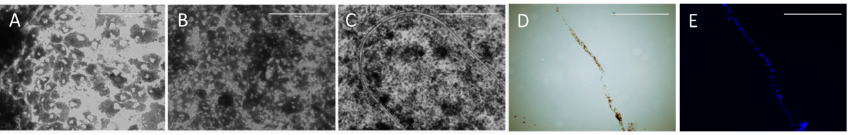
Figure 3. Morphology of the cultured hRPEs on the nanofibrous carrier. ( A ) Typical morphology of the cells between Days 15–44 (20 × magnification, scale bar = 200 µ m), ( B ) at Day 74 (20 × magnification, be stained by DAPI ( E ). scale bar = 200 µ m), and ( C ) at Day 74 (4 × magnification, scale bar = 1 mm). ( D ) Typical morphology of a cross-section of cultured hRPEs (10 × magnification, scale bar = 400 µ m), also found to be stained by DAPI ( E ).